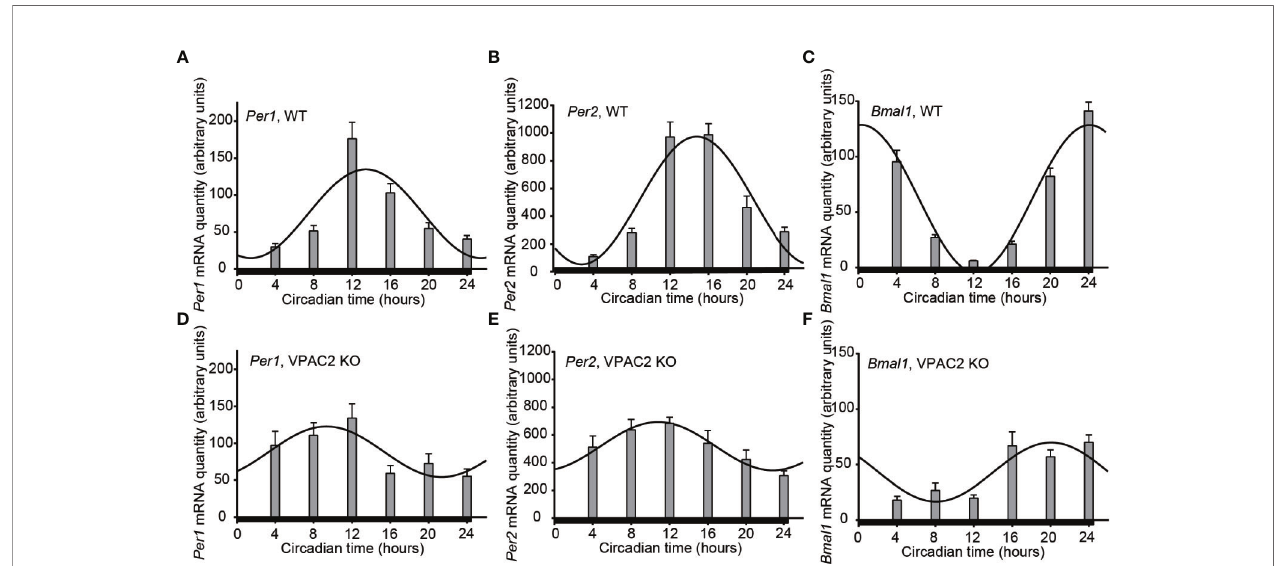
FIGURE 2 | Circadian oscillation of clock gene expression in thyroid glands from wild-type (WT) and VPAC2 receptor knockout (KO) mice. RNA from thyroid glands of animals during the second cycle of constant darkness was extracted, and the amounts of Per1 (A, D) , Per2 (B, E) , and Bmal1 (C, F) mRNA were quanti fi ed by qPCR. b 2- microglobulin amounts were used for normalisation. The results are given as mean arbitrary units ± SEM, n = 7 – 8, and WT and KO animals are shown in (A – F) respectively. In both groups of mice, the expression of all three clock genes displayed signi fi cant oscillation as a function of the 24 h (P < 0.001 for A – C, E, F , and P < 0.01 for D ). The curves show the 24 h cosinor fi ttings of the data. The black bar at the bottom of each graph represents the darkness during the tissue sampling period.